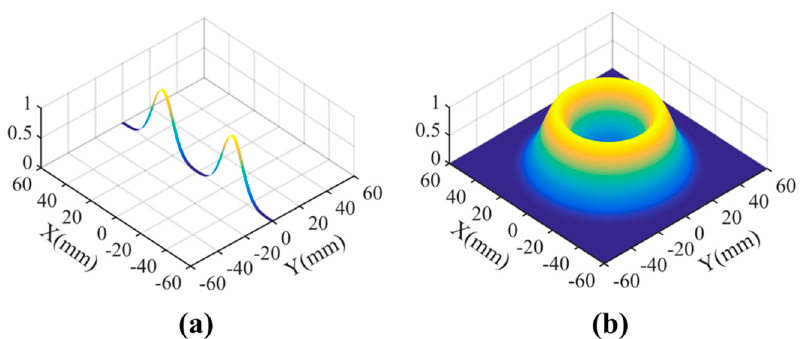
Figure 3. ( a ) Two-dimensional positional probability distribution of sputtered particles along the radial direction, calculated from the etched ring. ( b ) Three-dimensional positional probability distribution obtained by rotation.